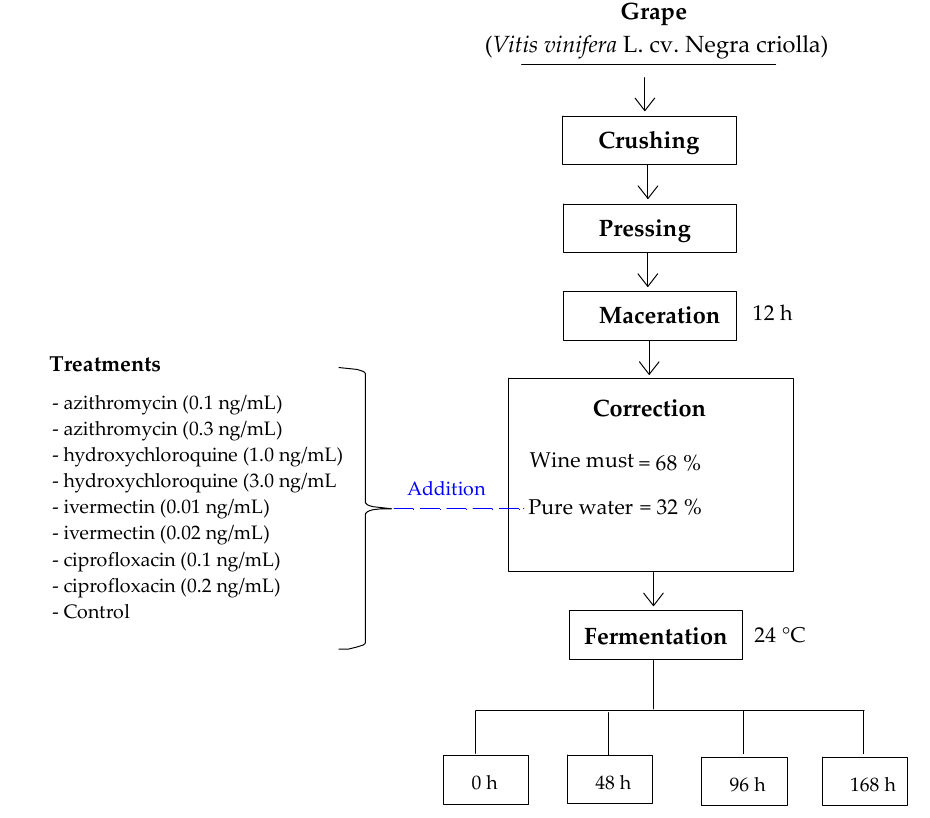
Figure 2. Graphical scheme of the study.